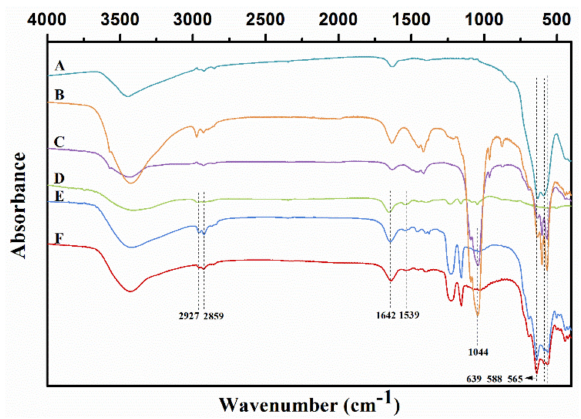
Figure 1. Spectra of ( A ) Fe 3 O 4 MNPs, ( B ) hydroxyapatite coated magnetic nanoparticles (HAP-coated MNPs), ( C ) 3-aminopropyltrimethoxysilane (APTES)-HAP-coated MNPs, ( D ) BCL CLEAs, ( E ) BCL mCLEAs, ( F ) Triton-activated BCL